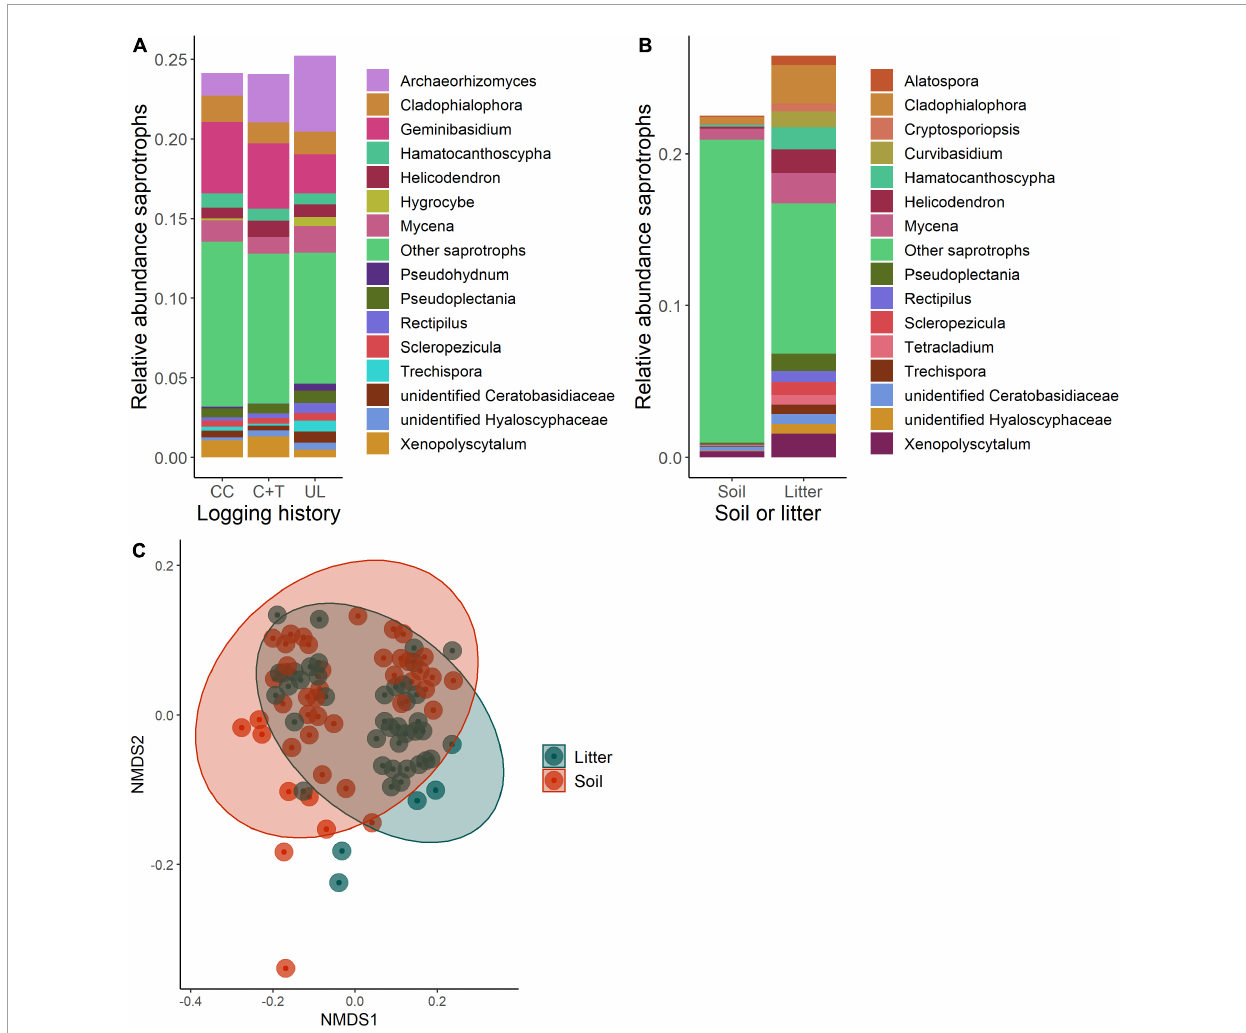
FIGURE4 Comparisons of saprotroph communities in soil and litter of logged and unlogged forest stands within the H. J. Andrews Forest, Oregon, USA. Clearcut (CC), watershed 6, canopy + thinned (C + T), watershed 7, unlogged (UL), watershed 8. (A) Relative abundances of saprotroph genera between watersheds. (B) Relative abundances of saprotroph genera between soil and litter. (C) NMDS ordination of saprotroph communities based on Bray-Curtis dissimilarities between soil and litter (PERMANOVA, p =